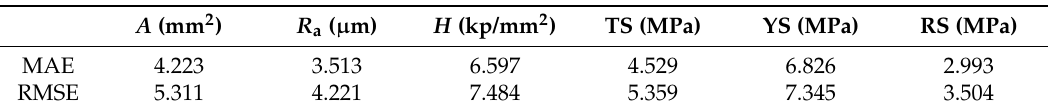
Table 9. Results of the predicted error criteria for area ( A ), roughness ( R a), hardness ( H ), yield stress (YS), tensile strength (TS) and residual stresses